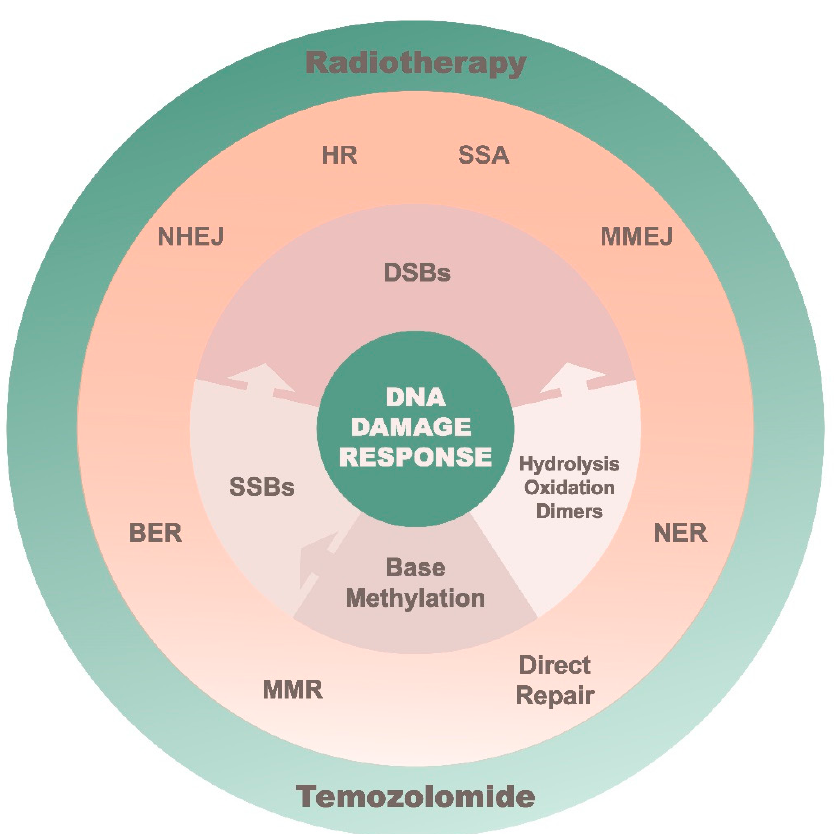
Figure 2. A summarized layout of the DNA repair system in combating different DNA